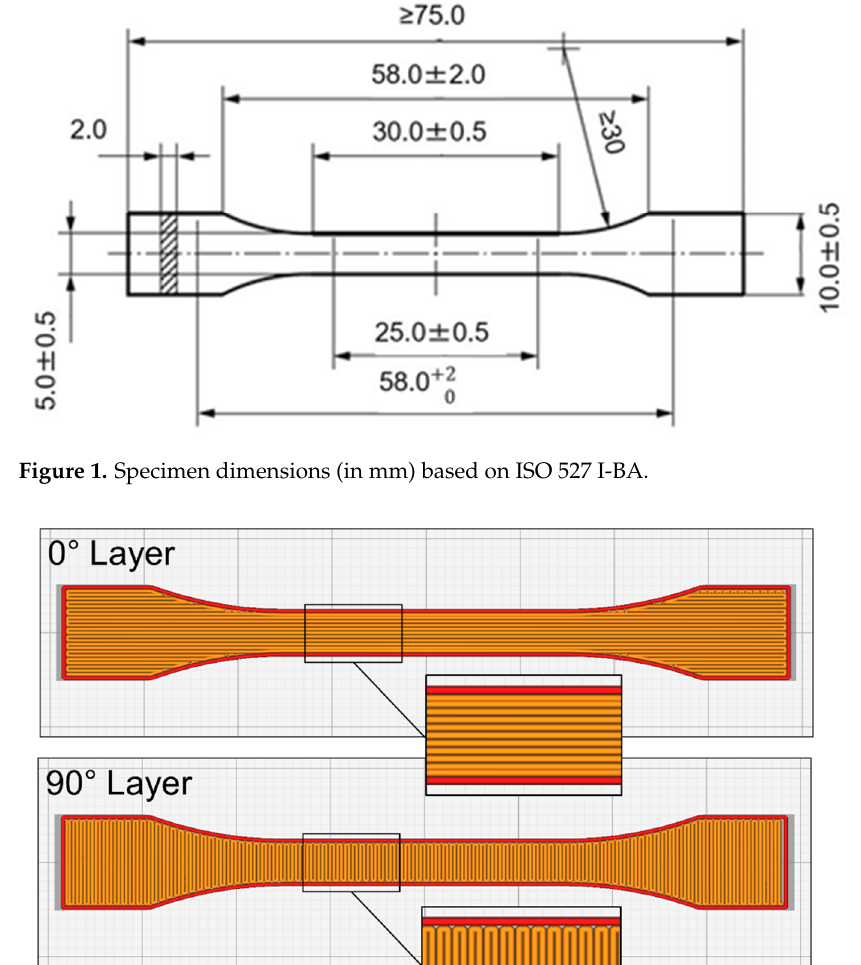
Table 1. Evaluated ranges of process